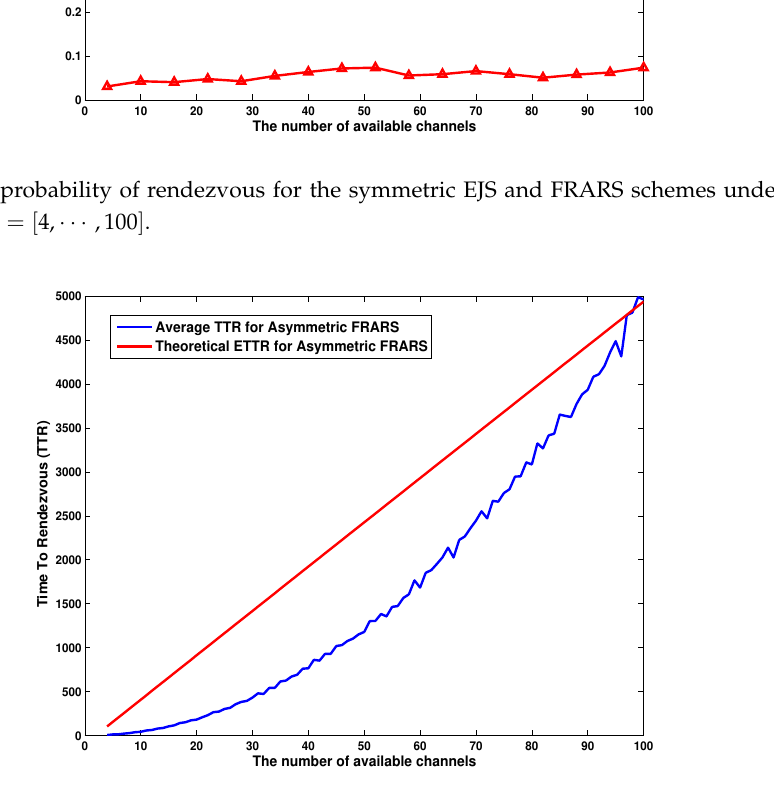
Figure 8. The average TTR and the theoretical ETTR for the asymmetric FRARS scheme with | m 1 | = | m | = | M | /2, M = [ 4, · · · ,100 ] , and G = 2